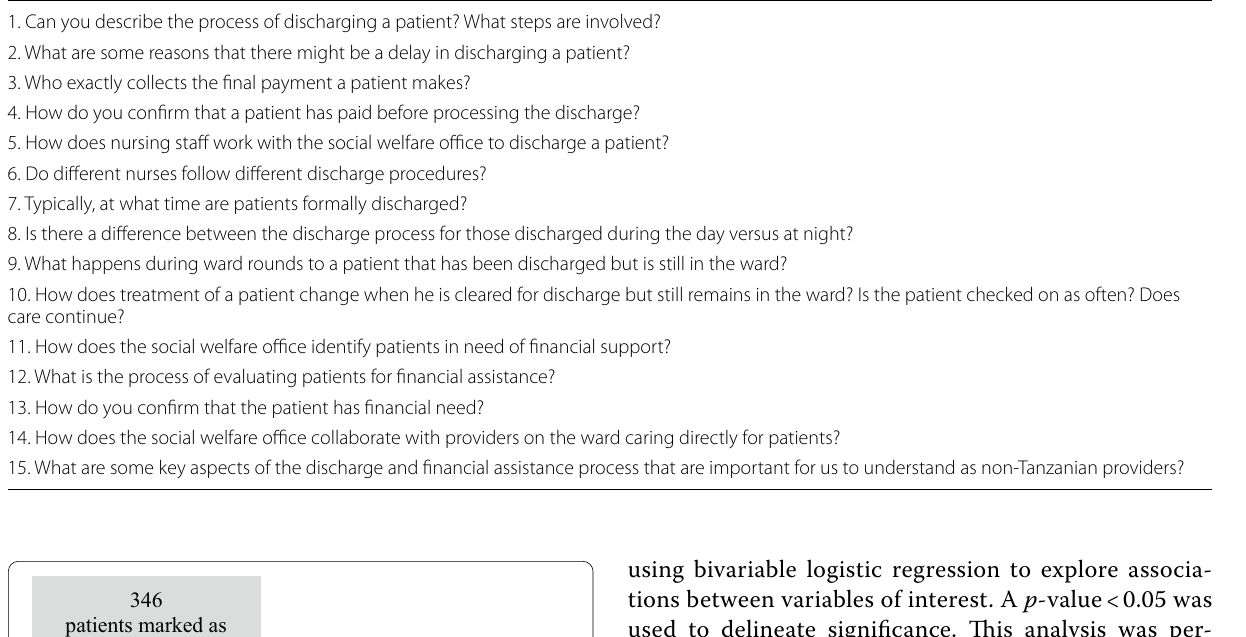
Table 1 Semi-structured interview question guide